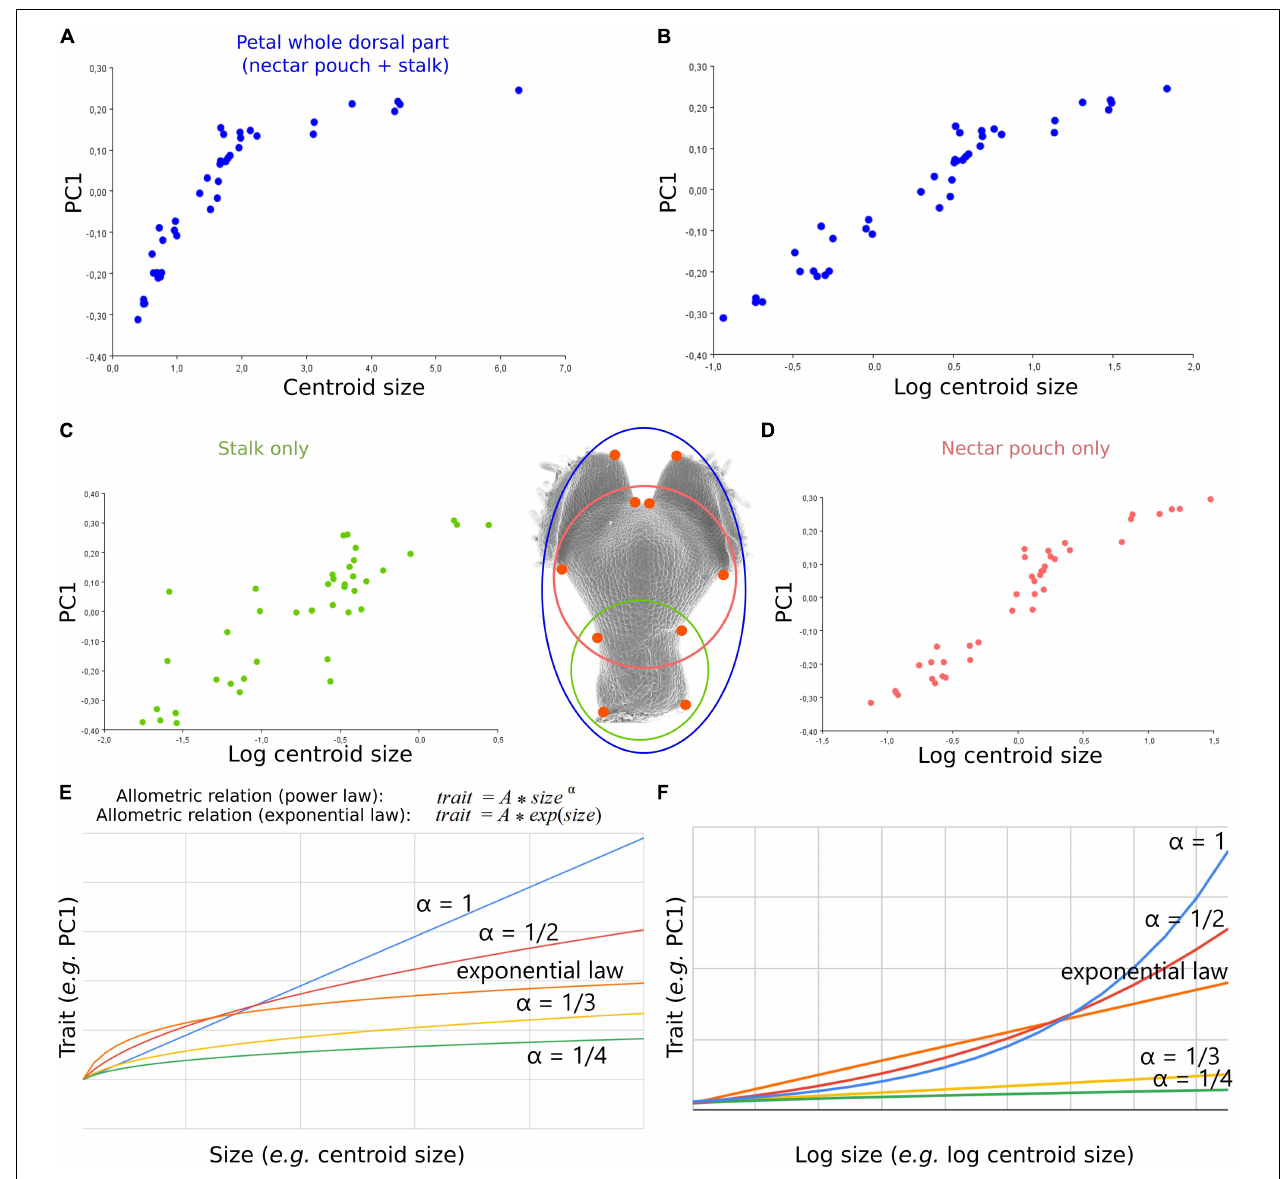
FIGURE 3 | An allometric relation, potentially exponential, links shape and size dynamics of N. damascena whole petal from dorsal view and its subdomains (stalk and nectar pouch) during morphogenesis. (A) The first axis of PCA of dorsal view plotted against centroid size (proxy of petal size) and log of centroid size, and (B) shows that their covariation is well approximated by an exponential law. The same analysis was performed on the subsets of landmarks delimiting stalk only (C) and nectar pouch only (D) . Comparison between exponential and power-law allometric relations of a trait (PC1 in this study) and size (E) or log size (F)